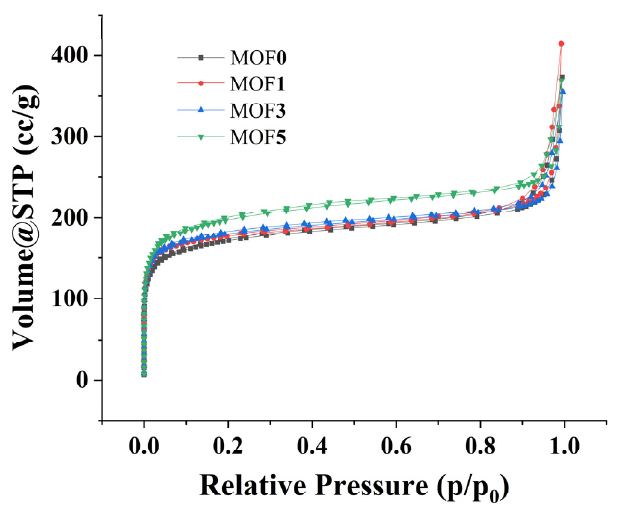
Figure 5. Nitrogen adsorption-desorption isotherms of the obtained MOF products.